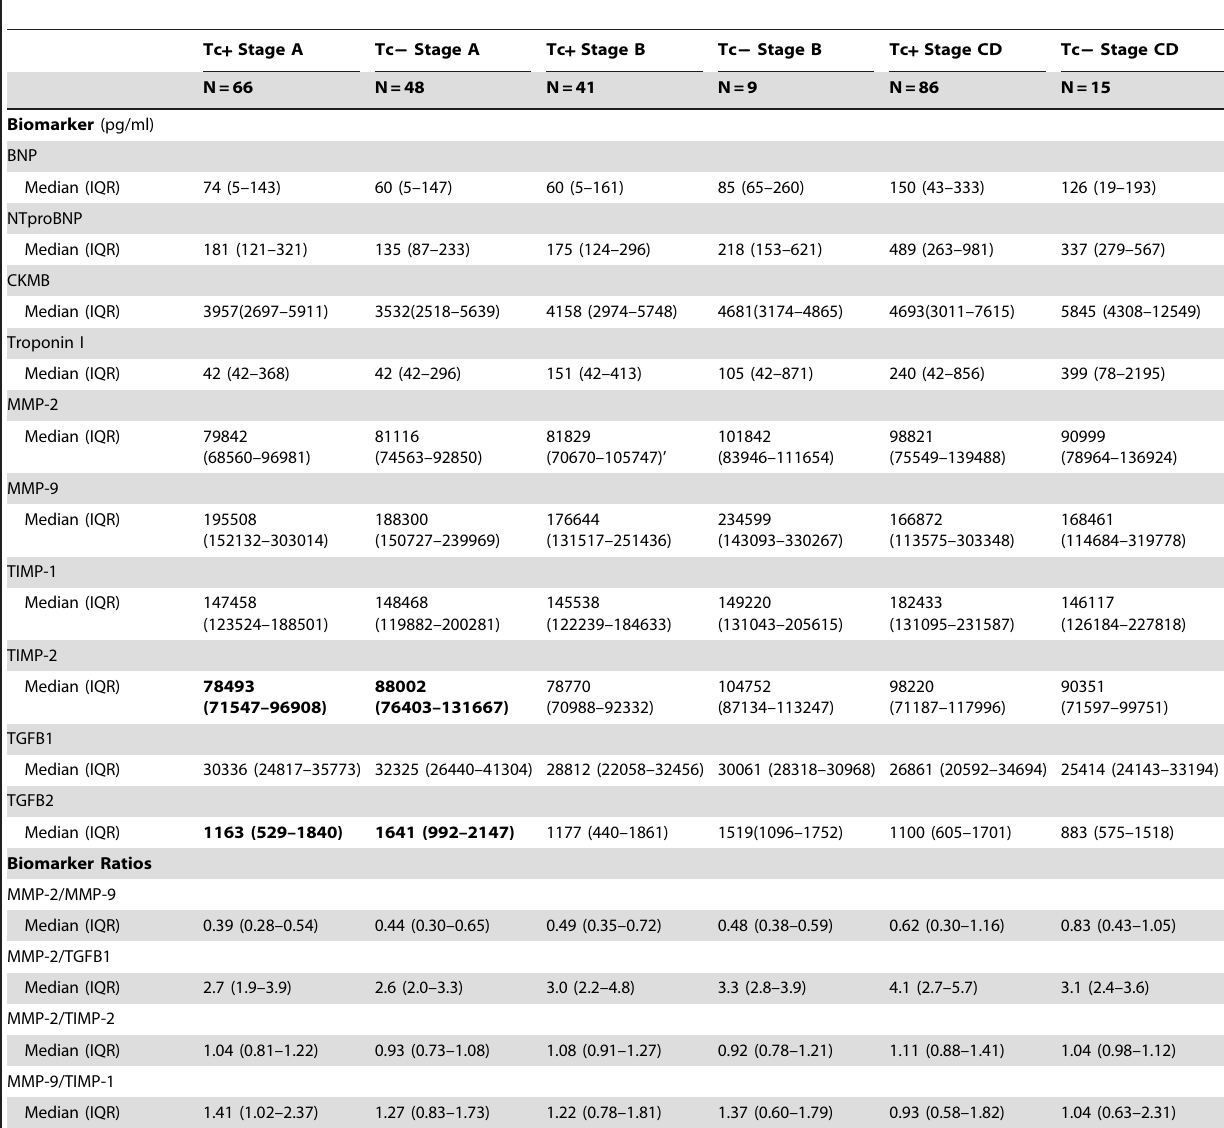
Table 2. Comparison of biomarkers and biomarker ratios in T. cruzi -infected (Tc + ) vs uninfected (Tc 2 ) subjects by